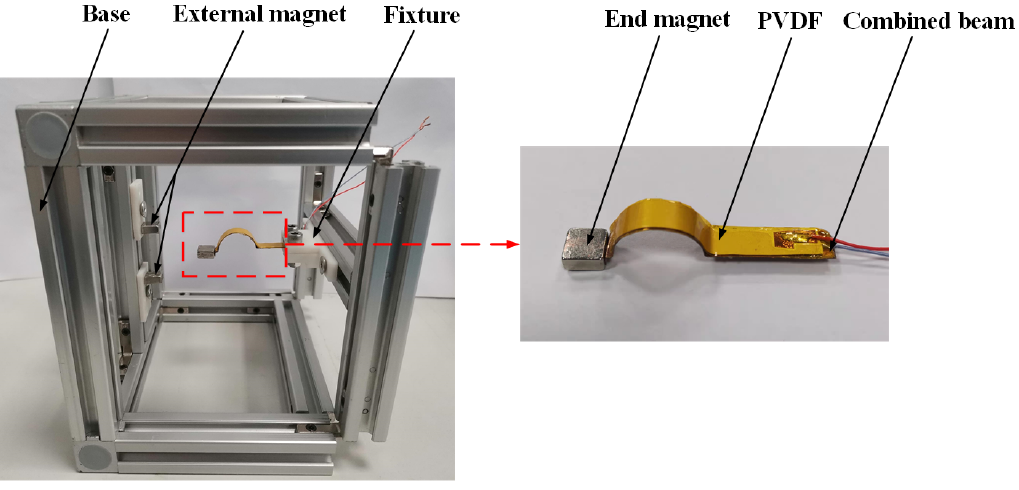
Figure 12. Experiment model machine of CTEHS.